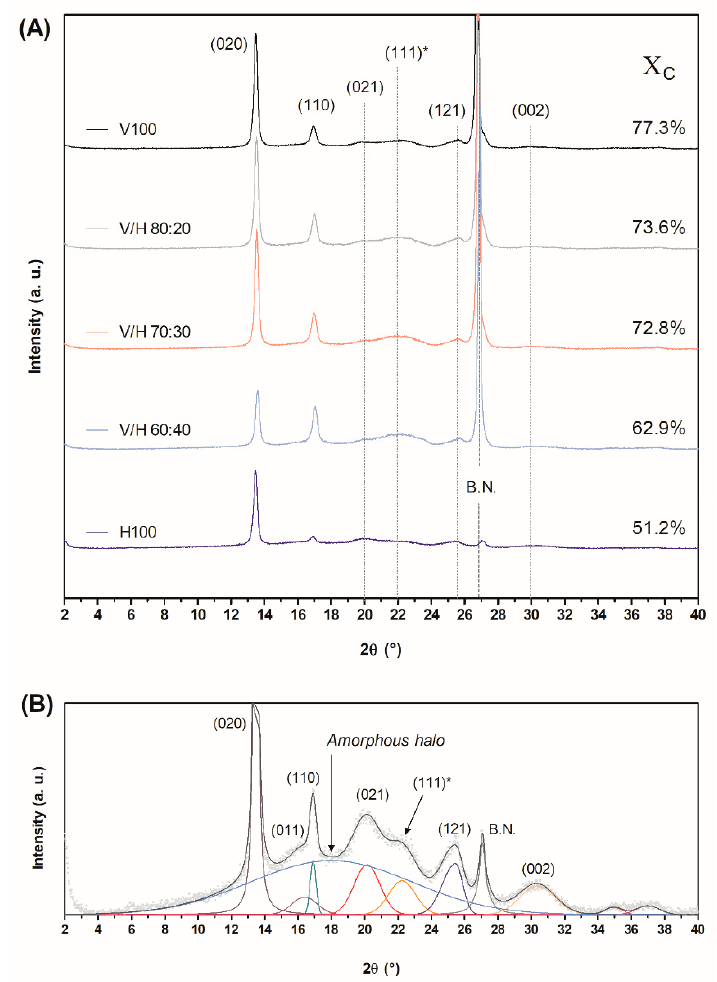
Figure 7. ( A ) X-ray-diffraction patterns of the poly(3-hydroxybutyrate- co -3-valerate) (PHBV), poly(3-hydroxybutyrate- co -3-hydroxyhexanoate) (PHBH), and their blends including the degree of crystallinity (X C ) on the right; ( B ) Peak deconvolution of neat PHBH diffractogram with a detailed amorphous halo.